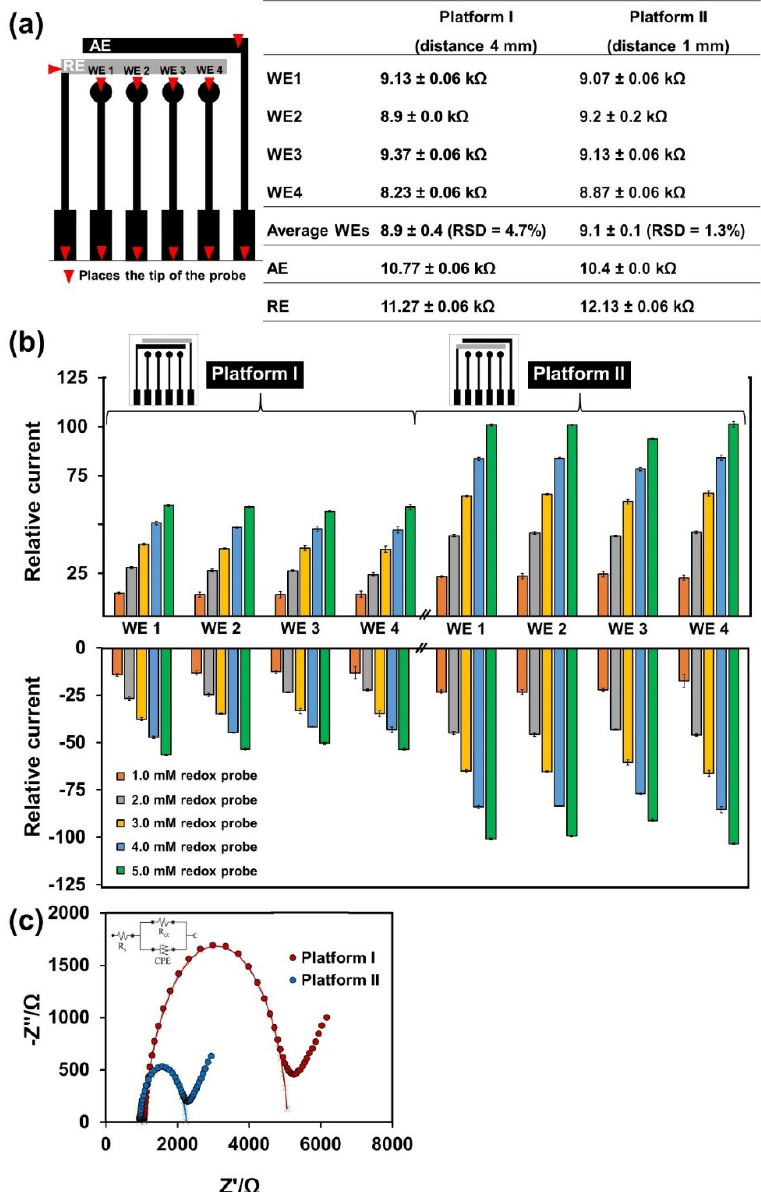
Figure 2. ( a ) The diagram showed the position for resistance measuring using digital multimeter and the table showed the resistance value of two different MGrEs with reference electrodes placed in different locations. ( b ) Histograms of the relative responses of the anodic peak current and cathodic peak current obtained from platform I (distance 4 mm) and platform II (distance 1 mm) in 0.1 M KCl solution containing series concentrations of Fe(CN 6 ) 3 − /4 − . ( c ) The EIS response of 5.0 mM